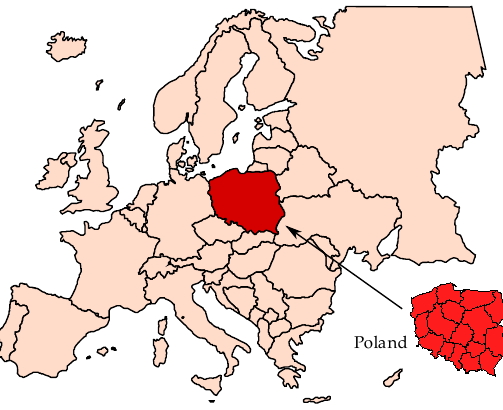
Figure 1. Location of the study region.